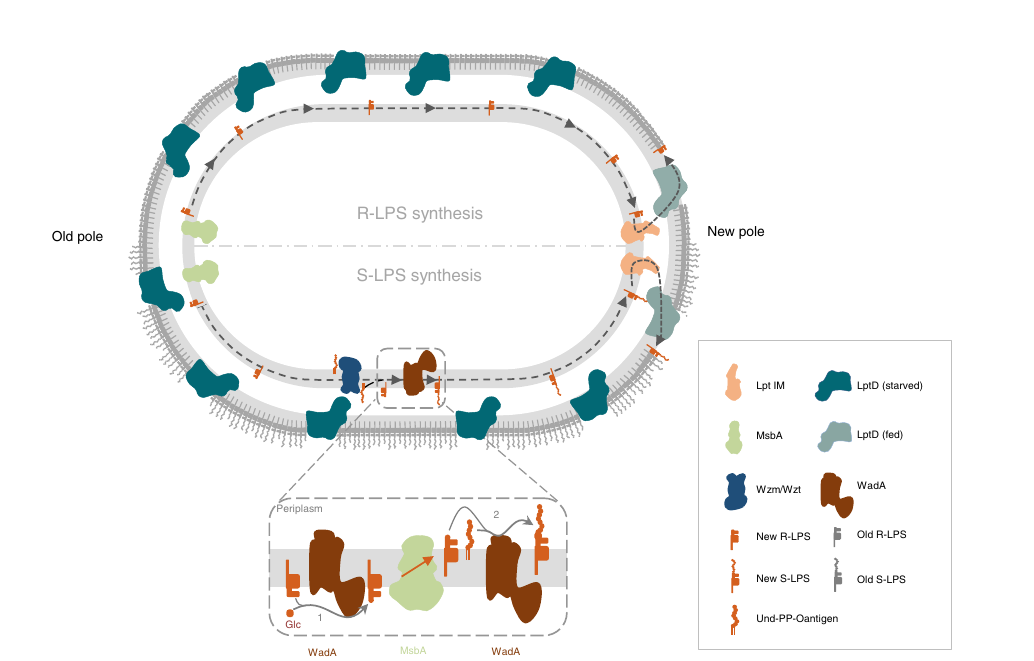
Fig. 9 | Schematic model localizing different actors involved in LPS synthesis and translocation of B. abortus . When synthesized, the R-LPS is anchored to the innerlea fl